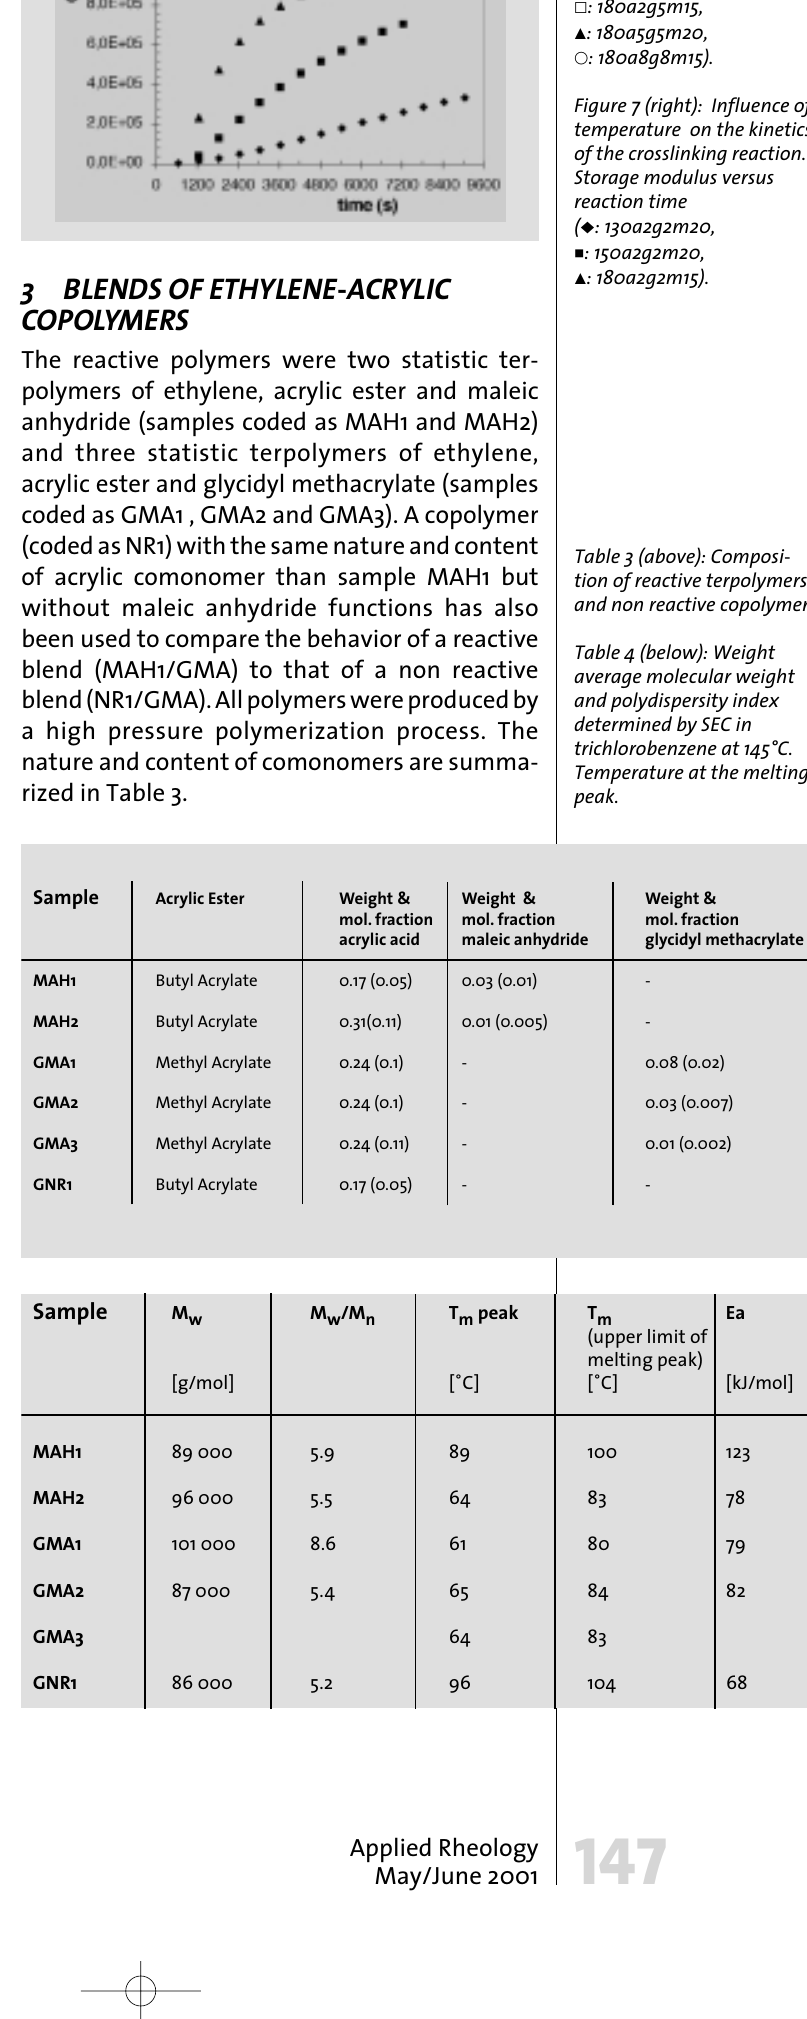
Figure 6 (left): Data of Fig. 5 plotted with reduced vari- ables: G’/[C]0 = f(t*[C]02) ( Ï : 180a2g2m15, · : 180a2g5m15, Ú : 180a5g5m20, Á : 180a8g8m15). Figure 7 (right): Influence of temperature on the kinetics of the crosslinking reaction. Storage modulus versus reaction time ( Ï : 130a2g2m20, ‚ : 150a2g2m20, Ú : 180a2g2m15).